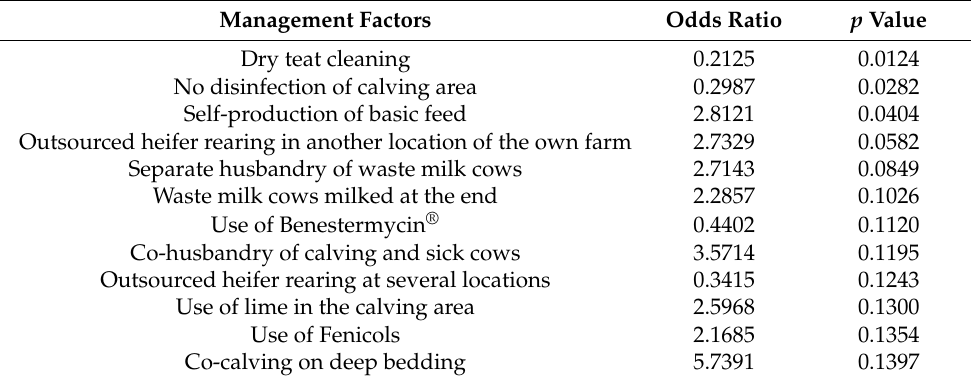
Table 6. Results of the association between the parameters and the level of the maternal ESBL/AmpC- E. coli prevalence according to the univariable logistic regression